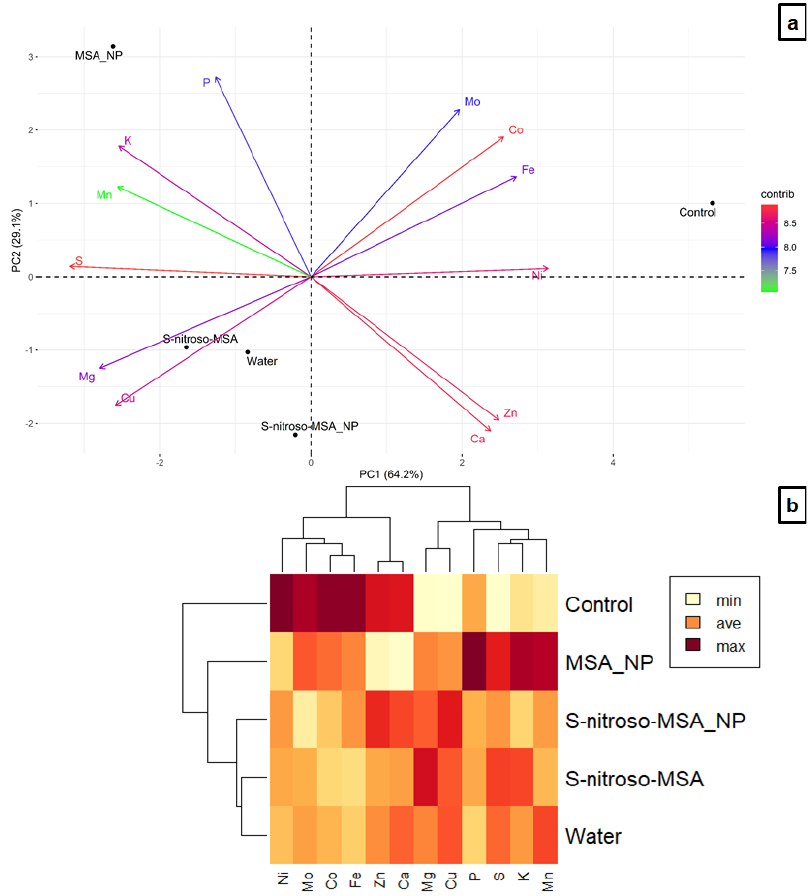
Figure 12. Principal component analysis ( a ), and heatmap hierarchical clustering analysis ( b ) of the essential nutrients in the roots of soybean plants cultivated in soil, containing different copper (Cu) levels (natural content: 11 mg kg ₋ 1 ; moderate Cu stress: 164 mg kg ₋ 1 ). Control = treatment with dis- tilled water and soil with natural copper content; water = treatment with distilled water after Cu addition; S-nitroso-MSA_NP = treatment with a nanoencapsulated NO donor (S-nitroso-mercapto- succinic acid) at 1 mM and soil with copper supplementation; S-nitroso-MSA = treatment with a NO donor (S-nitroso-mercaptosuccinic acid) in the free form at 1 mM and soil with copper supplemen- tation; MSA_NP = treatment with nanoparticles containing the non-nitrosated MSA at 1 mM and soil with copper supplementation. Data are the average of the four replicates per treatment.